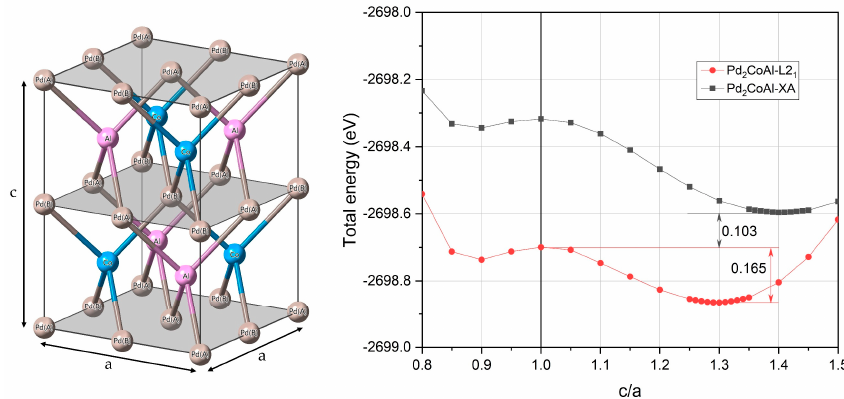
Figure 6. The tetragonal L2 1 -type crystal structure for the full Heusler compound Pd 2 CoAl and the calculated total energies with two crystal structures under di ff erent tetragonal structures. calculated total energies with two crystal structures under different tetragonal structures.